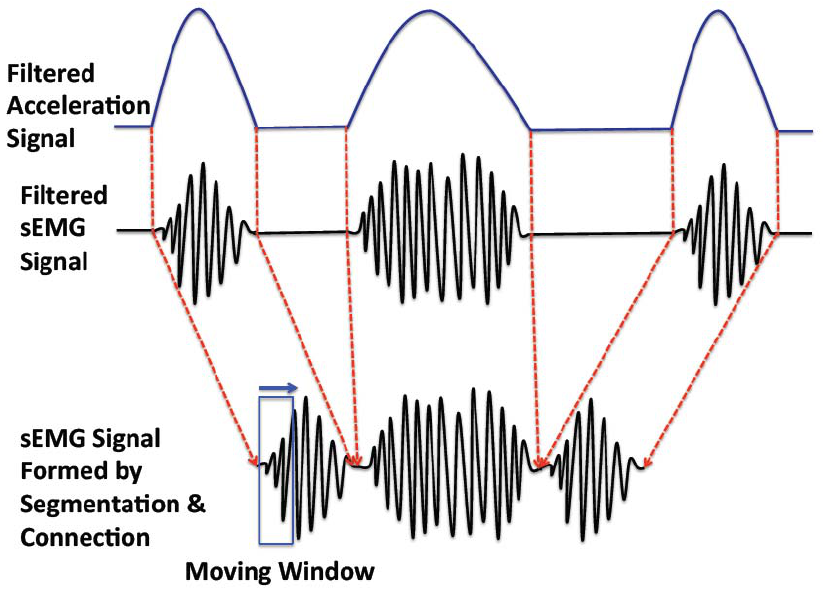
Figure 4. Segmentation and connection of the sEMG signal. The filtered sEMG signal is segmented based on the periodic movement pattern. The active sEMG signal parts are connected to form a new sEMG signal for the following moving window